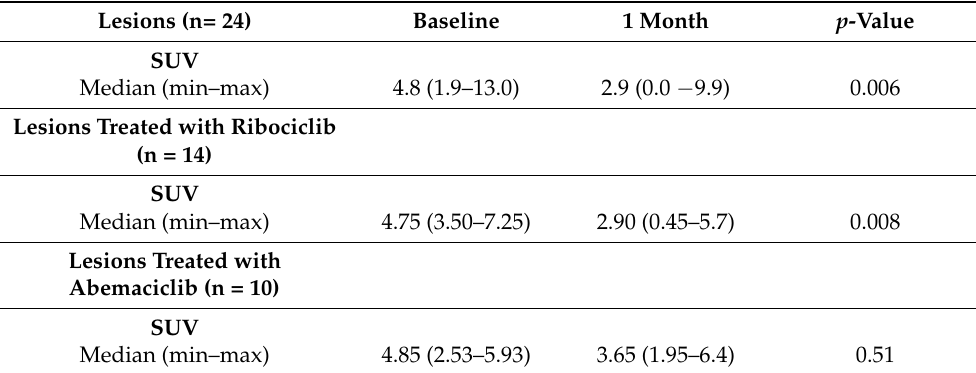
ribociclib reached statistical significance ( p = 0.008), with a decrease in median SUV max from an average value of 4.75 at diagnosis to 2.9 at the end of treatment. Those lesions treated with abemaciclib, although showing a decreasing trend for SUV max , did not achieve statistical relevance (Figure 3). Table 4. Comparison of SUV variation between baseline and after 1 month of therapy. Lesions (n= 24) Baseline 1